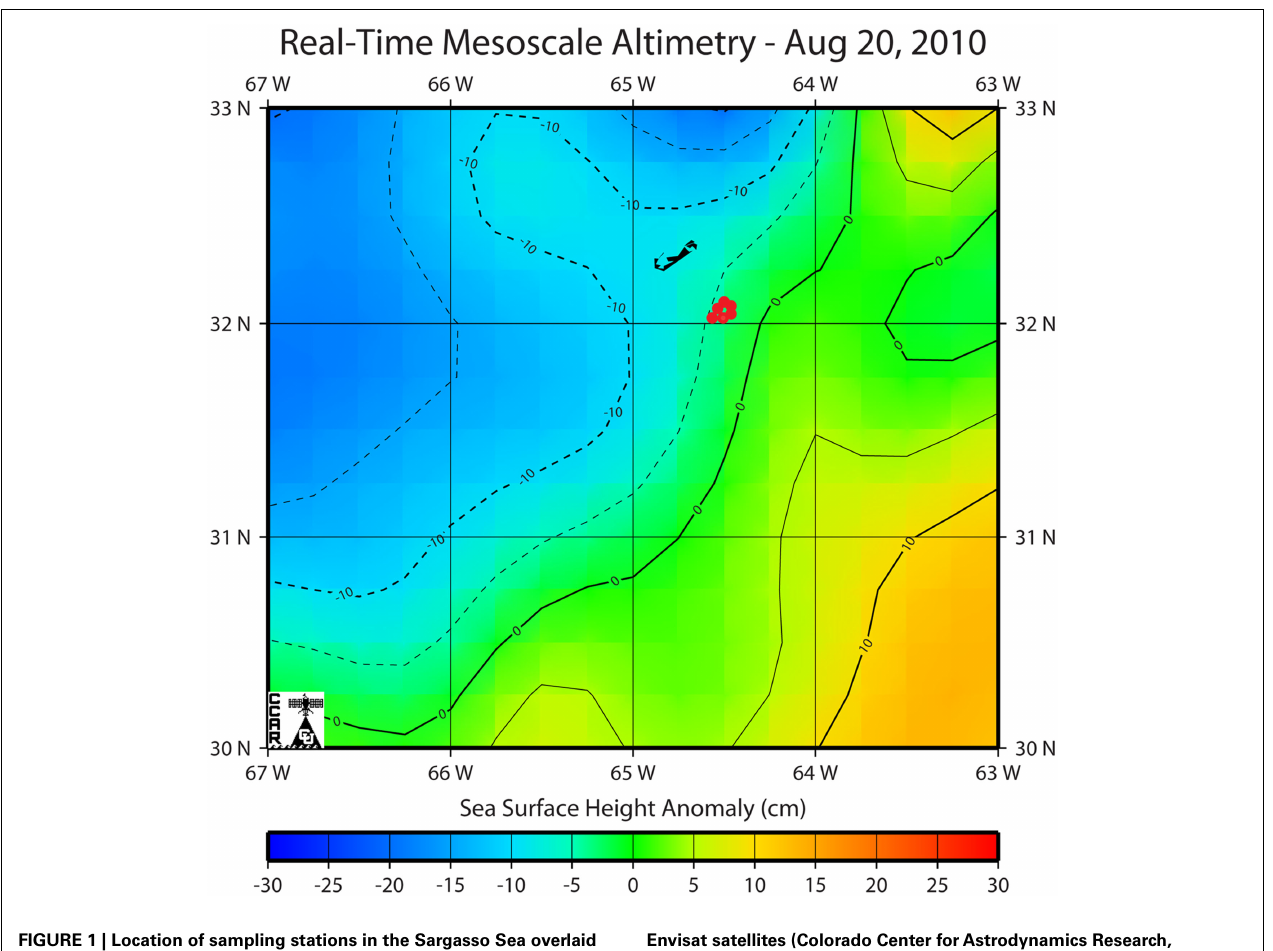
FIGURE 1 | Location of sampling stations in the Sargasso Sea overlaid on a map of sea surface height anomaly as determined by remote sensing from Jason,TOPEX/Poseidon, Geosat Follow-On, ERS-2 and